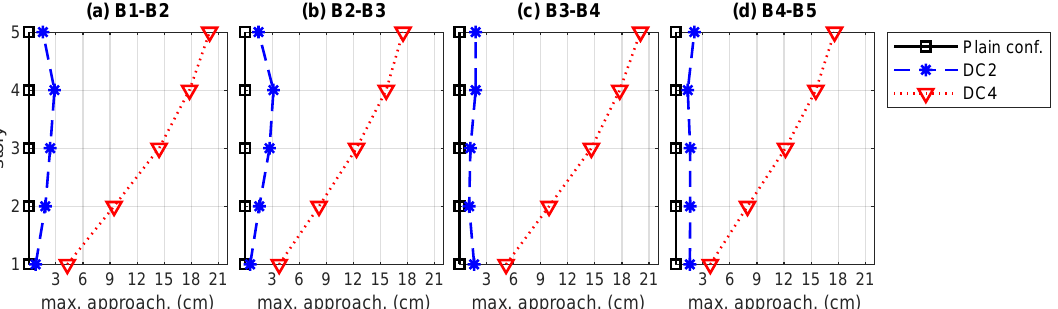
Figure 15. Maximum interbuilding approachings produced by the nonactuated multibuilding system (plain configuration), the linked configuration DC2 and the unlinked configuration